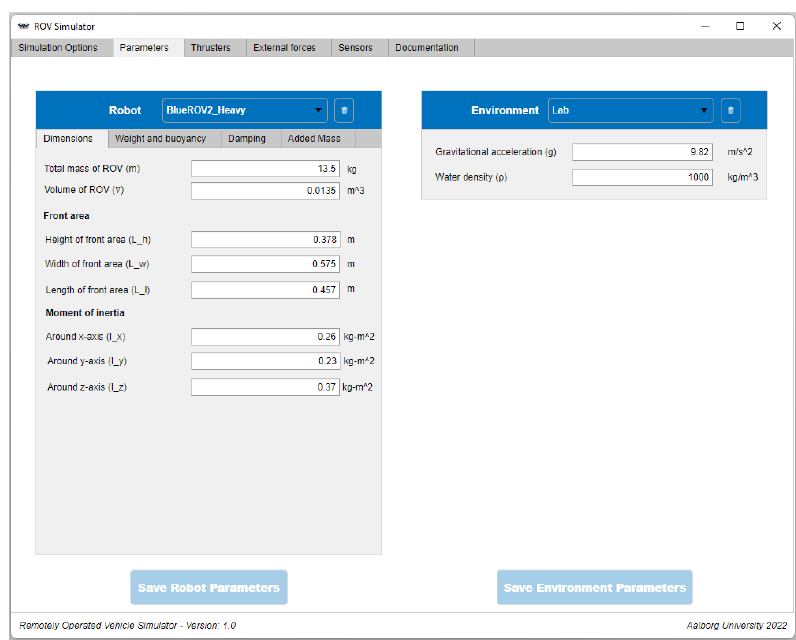
Figure A3. Overview of the robot and environment parameters pane within the ROV simulator